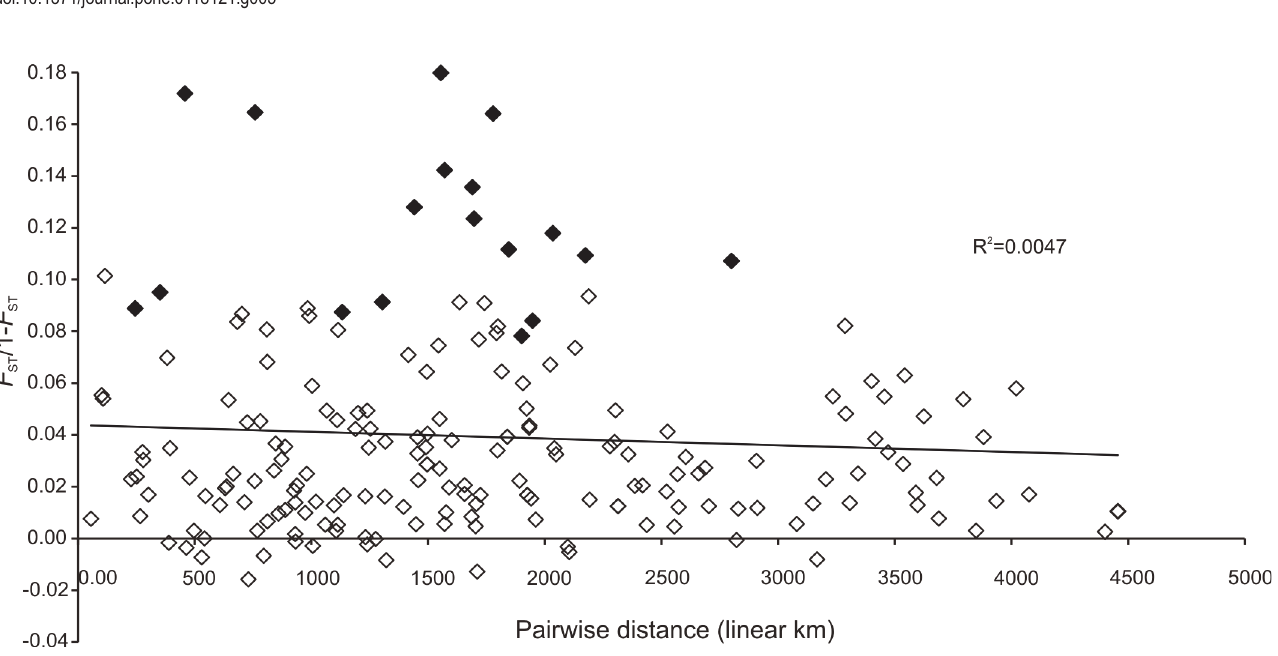
Fig 6. Plot of pairwise F ST (seven microsatellite loci) versus pairwise linear distance of 20 populations of Dikerogammarus villosus encompassing source populations for the Western Route (WR), the WR itself and populations in the western front in Poland. Black diamonds highlight pairwise comparisons with Vah river site (site 16), see text for